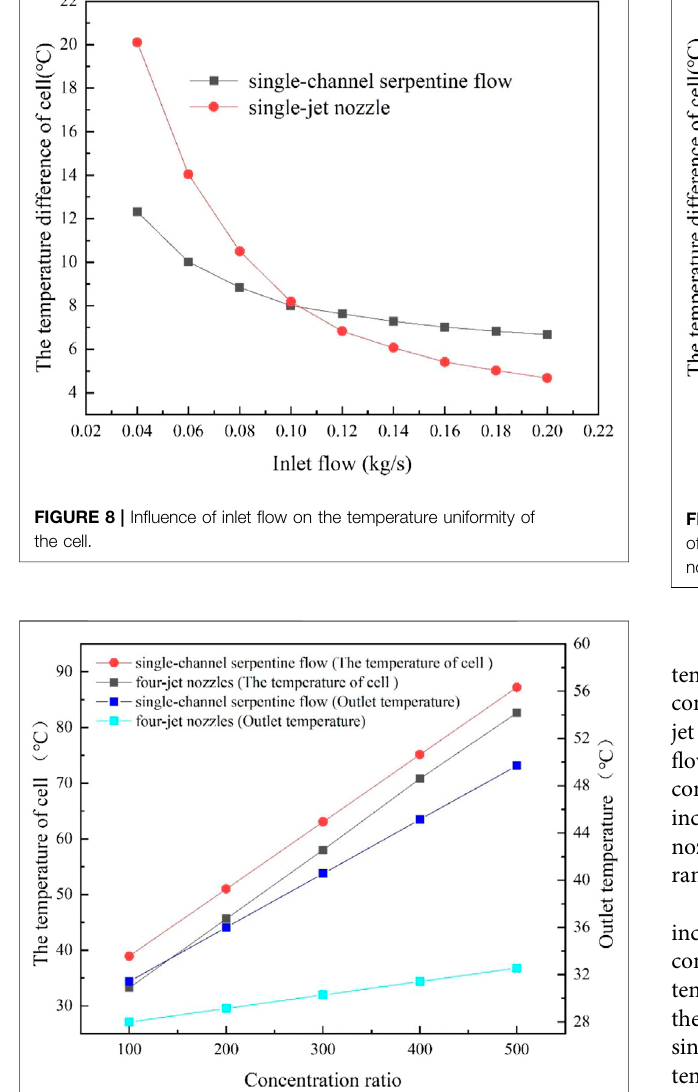
FIGURE 9 | In fl uence of concentration ratio on cell temperature and outlet temperature under the four-jet nozzles and single-channel serpentine fl ow.